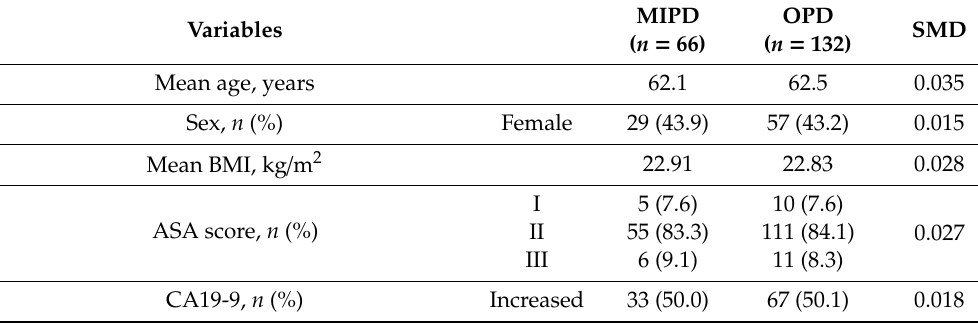
Table 9. Demographics and pathologic outcome of MIPD and OPD after propensity score matching with pathologic